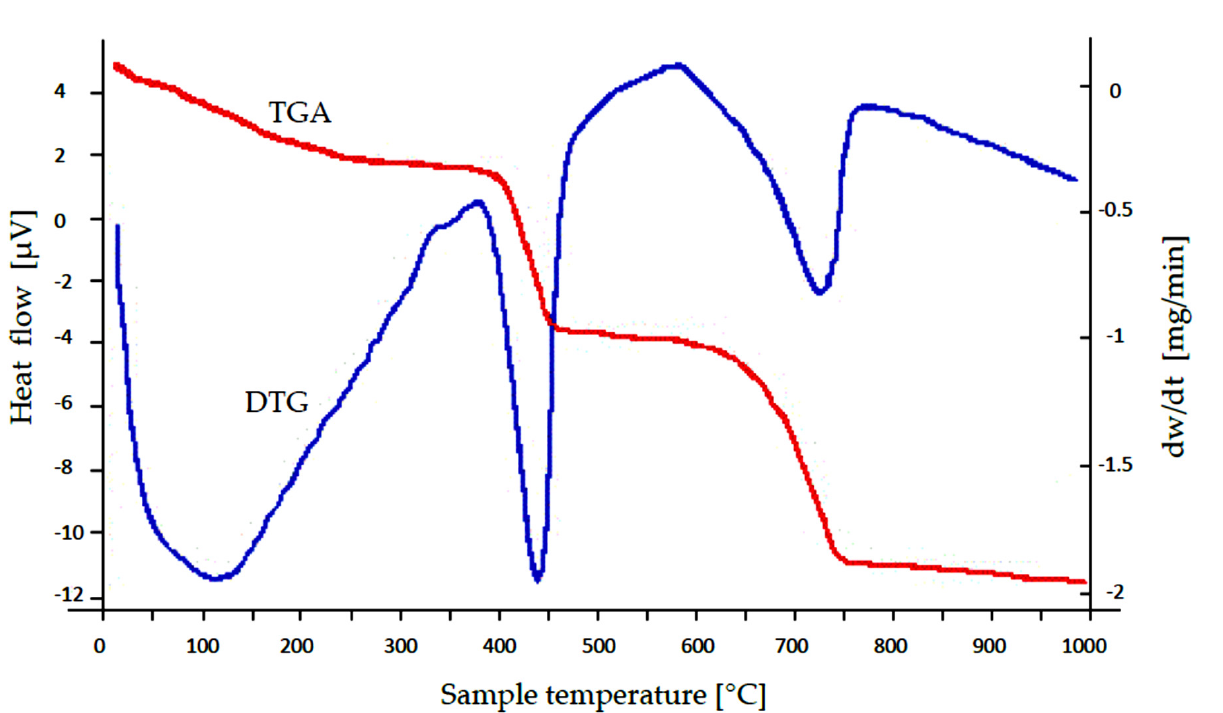
Figure 2. Thermogravimetric curves of SS-FA.